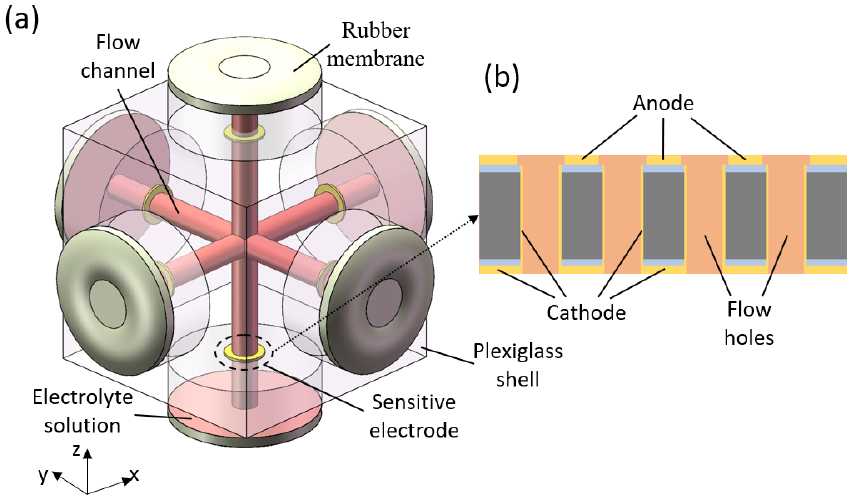
Figure 1. ( a ) Schematic diagram of the micro-electromechanical systems (MEMS) based integrated triaxial electrochemical seismometer developed in this study, consisting of (1) six rubber membranes, (2) six sensitive electrodes, (3) three orthogonal flow channels, (4) an electrolyte solution, and (5) a plexiglass shell; ( b ) enlarged schematic diagram of the sensitive electrode with (6) a cathode, (7) an anode, and (8) a large number of flow holes integrated on one chip.